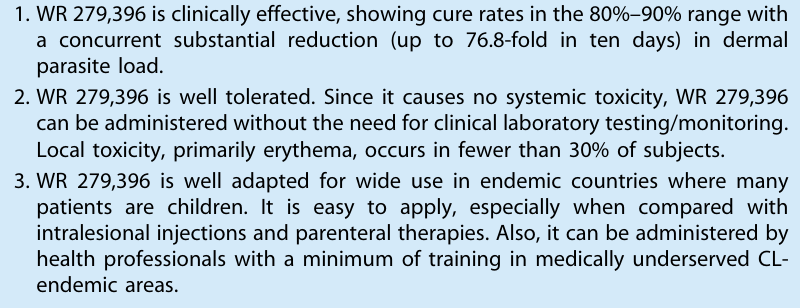
5) ranged from 0.66 to 195.36 m g/g in the superficial dermis and from 0.73 to12.08 m g/g in the deep dermis at that time. In comparison, when paromomycin is administered in- tramuscularly for VL, peak plasma levels range from 18.3 m g/mL ( 6 8.86)